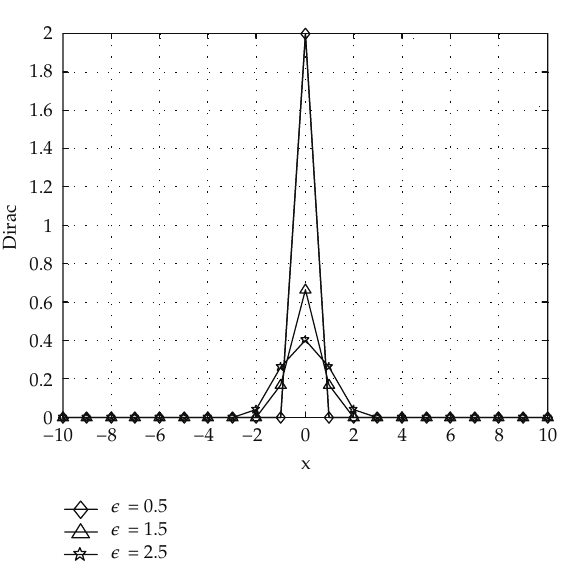
Figure 1: The Dirac function with di ff erent epsilon